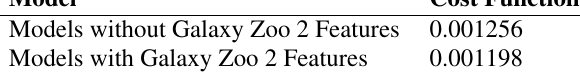
Table 2. Performance of Galaxy Zoo 2